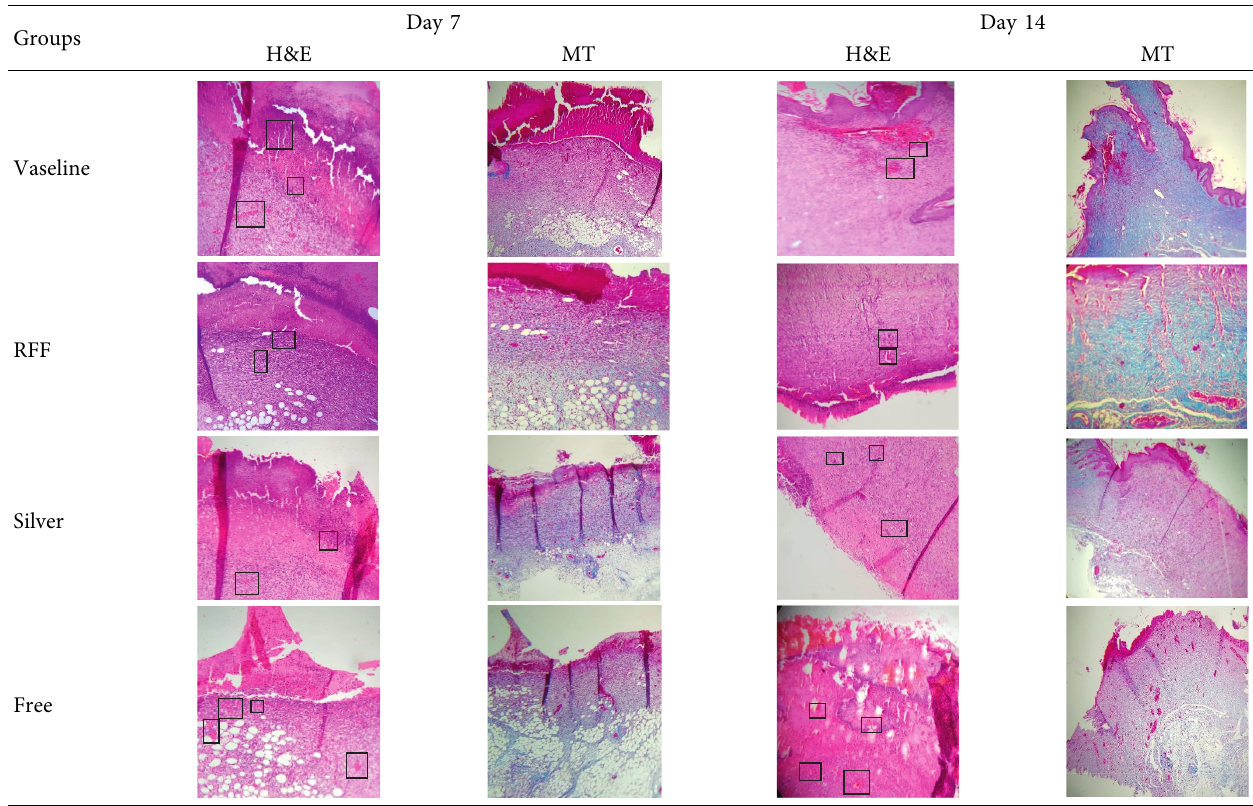
Table 5: Microscopic images (40 × ) of different treatment groups tissue samples after being stained with H&E and MTon days 7 and 14 after treatment (blue zone indicates the fibroblast proliferation). Squares represent morphology changes such as edema, congestion, inflam- mation, necrosis, and angiogenesis during experimental